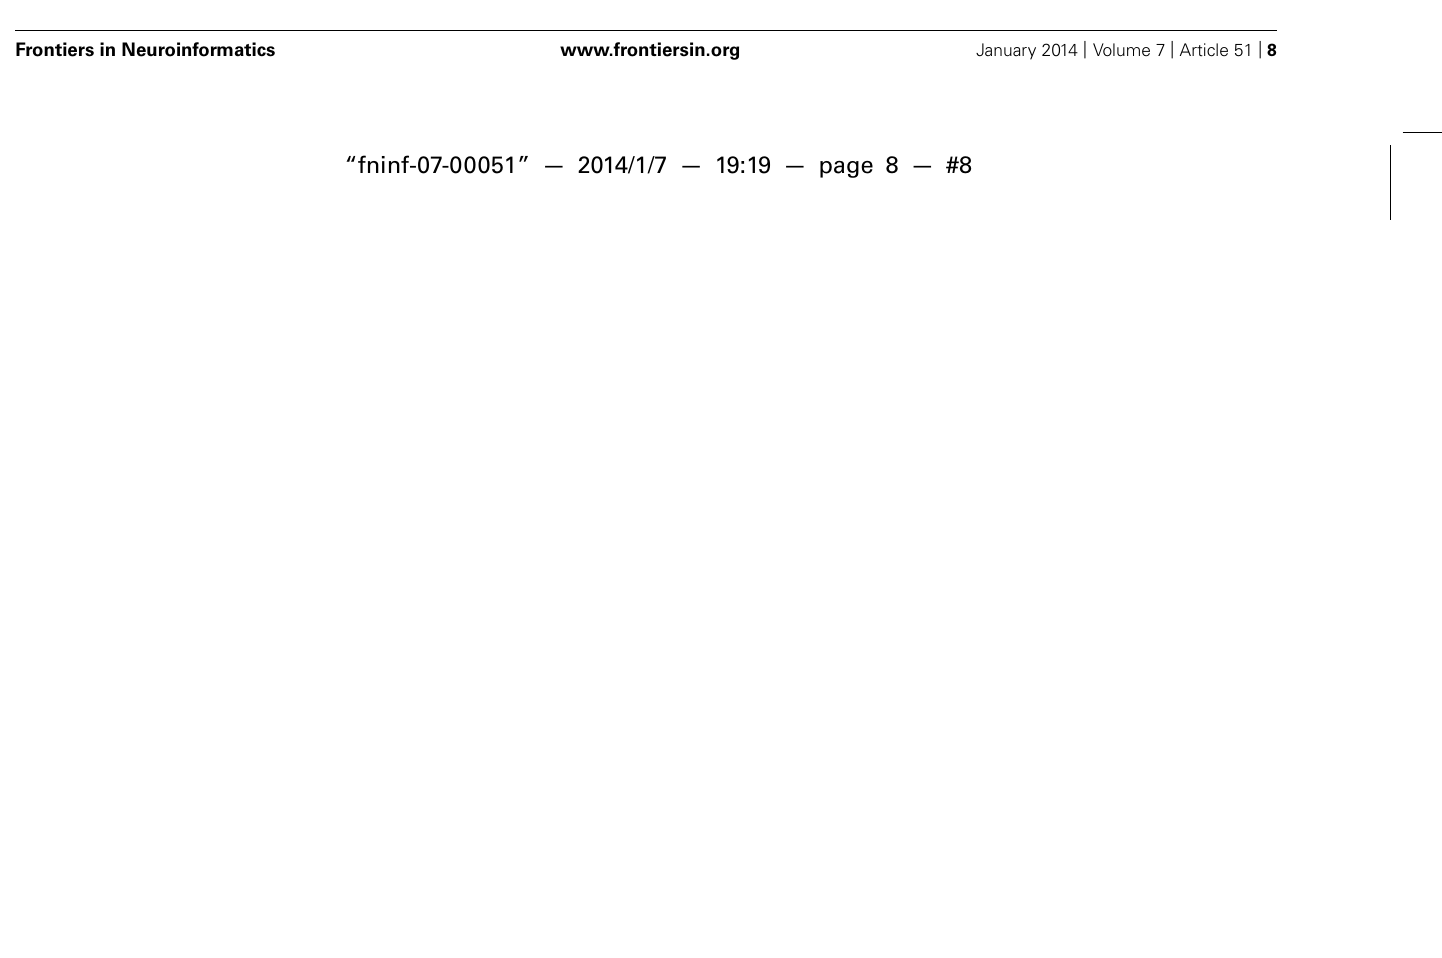
FIGURE 7 | DTIAtlasFiberAnalyzer GUI. (A) In the first tab of this tool the input data is defined: the label for each participant, the original quality controlled skull-stripped DTI, and the GlobalDeformationField computed in Atlas Building. (B) After DTIAtlasFiberAnalyzer has sampled the intended diffusion parameters, DTI property profiles for individual images (green) and the DTI atlas (blue) can be visualized in the Plot Parameters tab. Inspecting these profiles allows for a different type of quality control of the atlas